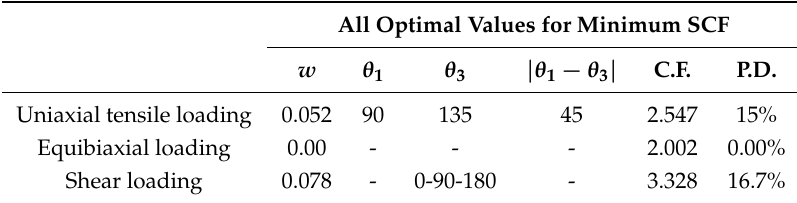
Table 6. All optimal values of design parameters for quasi-square cutout in isotropic plate ( c = 1).